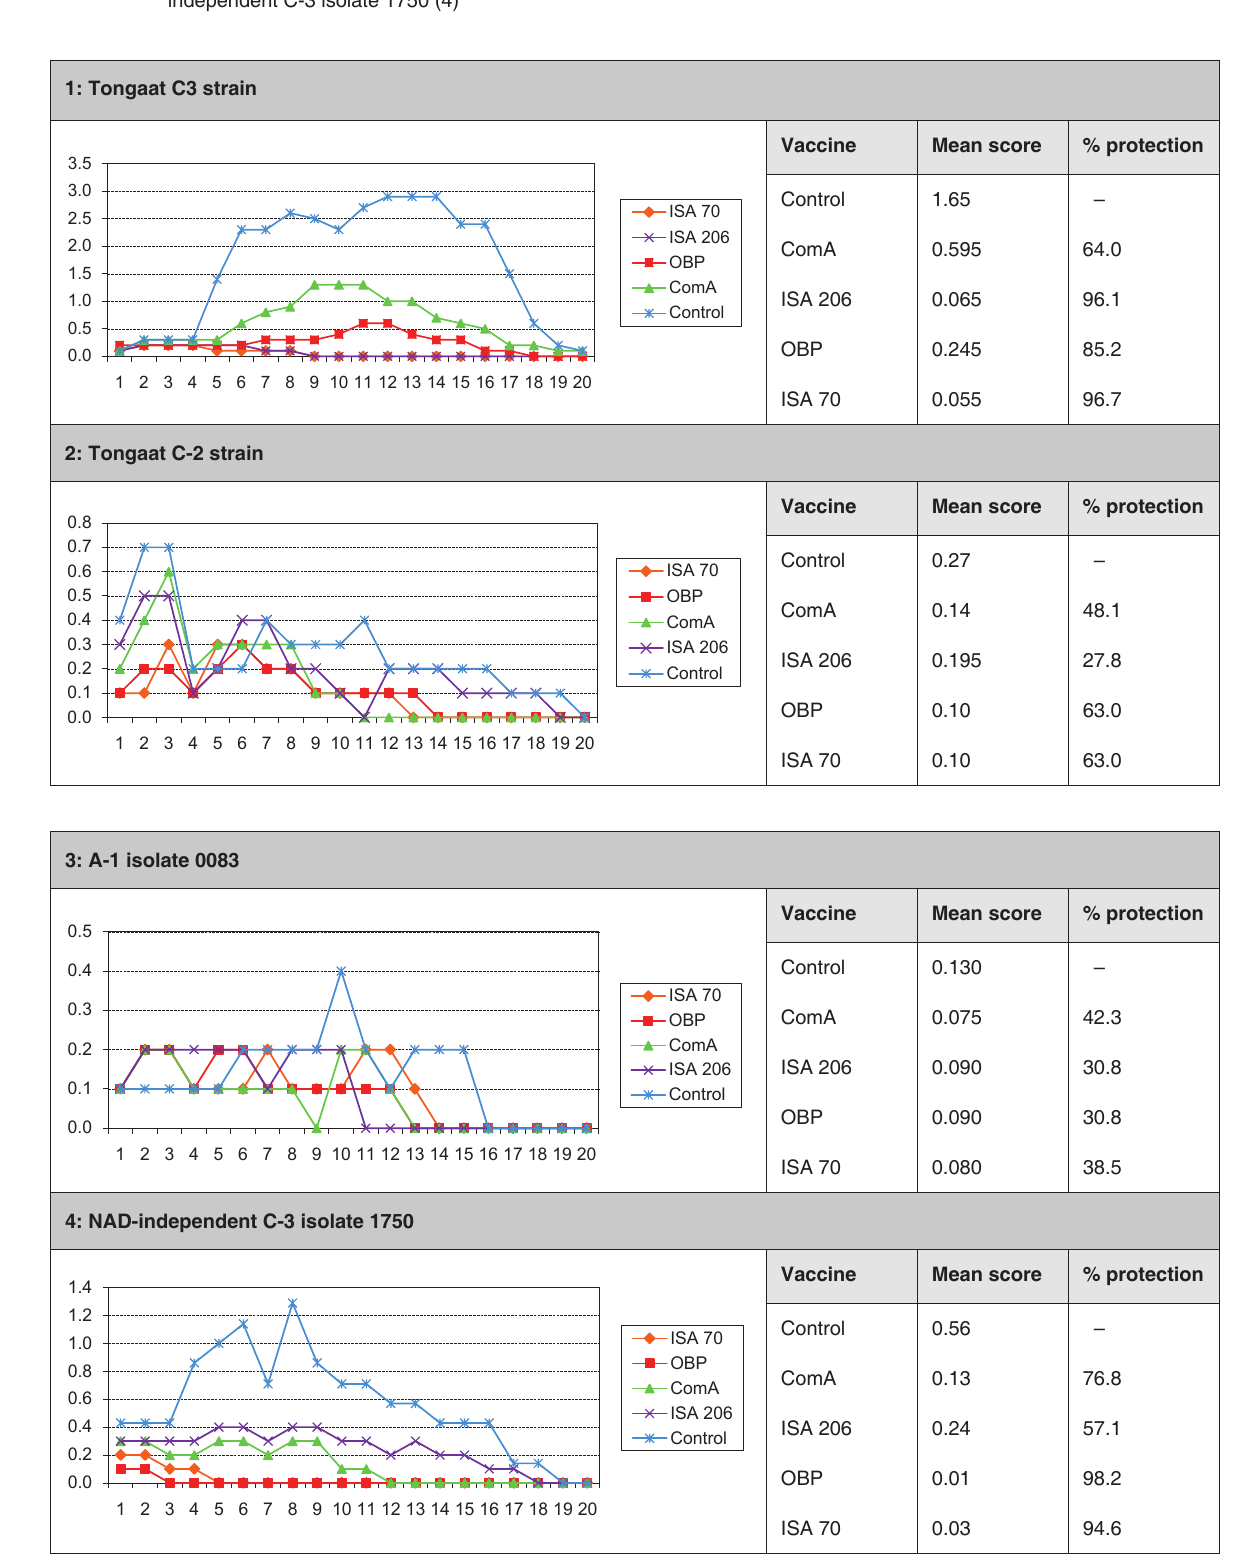
TABLE 3B Second vaccination: Graphic representation of the daily protection scores provided by each of the vaccines for chickens challenged with different A. paragallinarum challenge strains and table summarizing the corresponding mean lesion score and percentage protection—the Tongaat (C-3) strain (1); C-2 strain (2); the A-1 isolate 0083 (3); and the NAD- independent C-3 isolate 1750